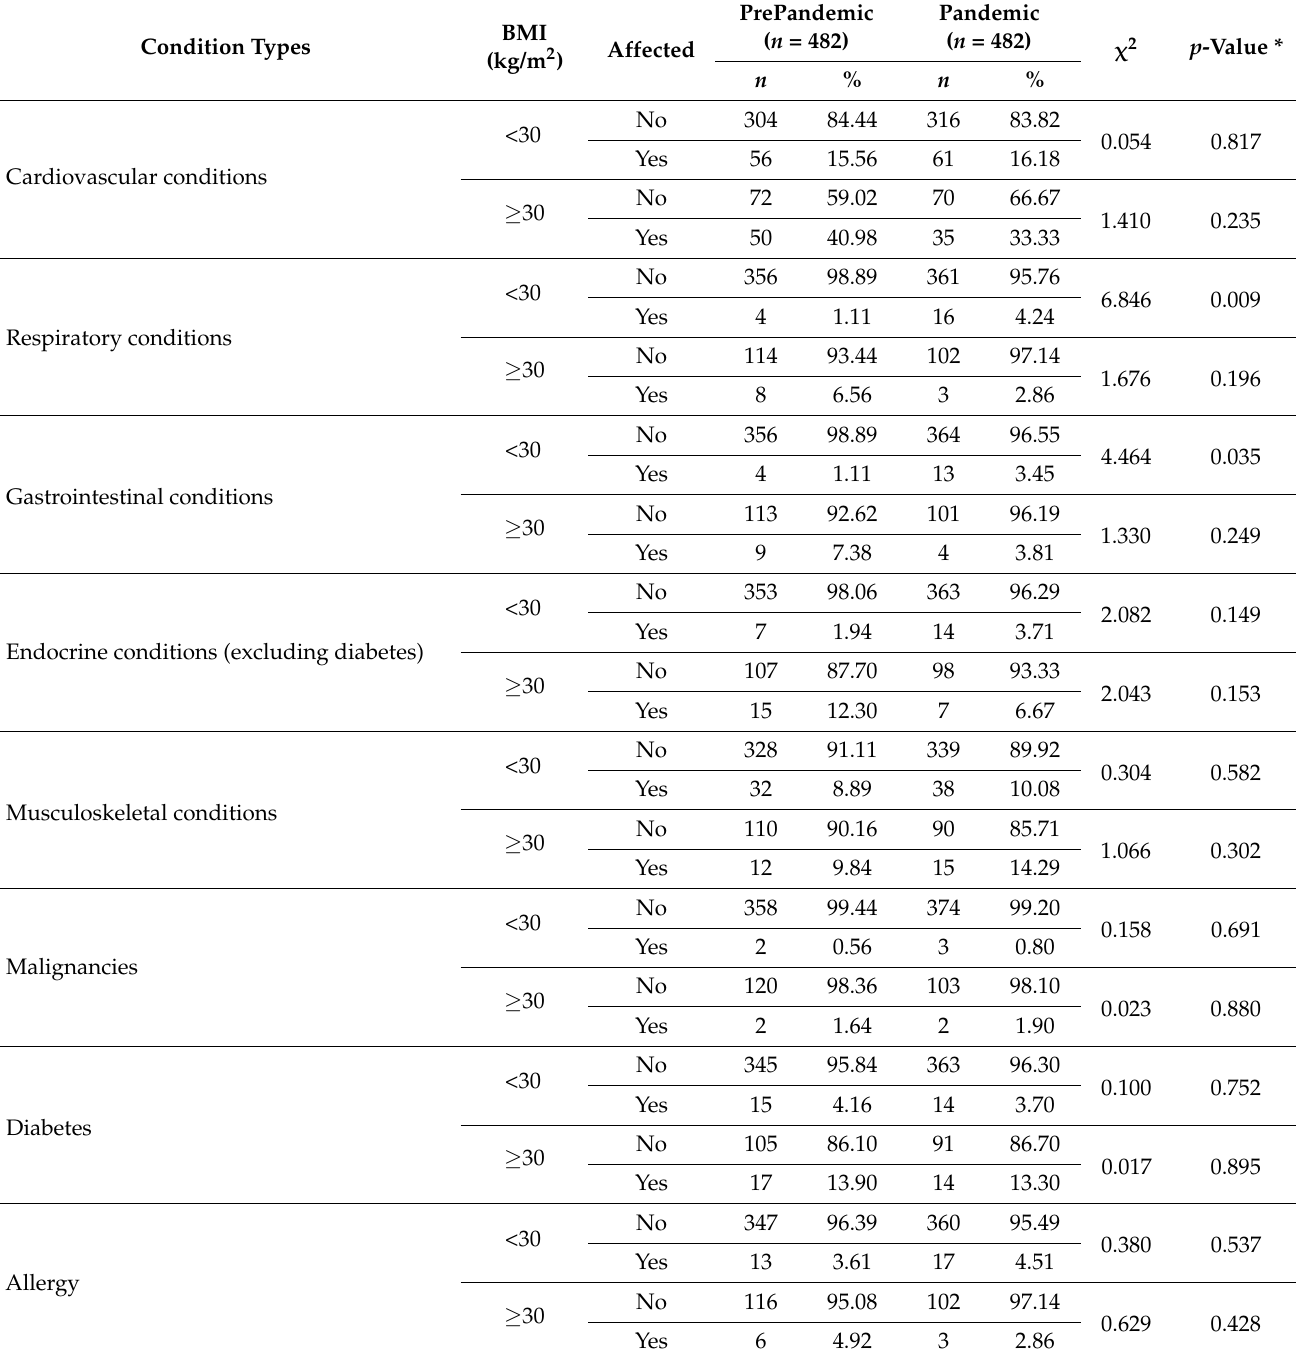
Table 4. Comparison of the rates of selected conditions between study